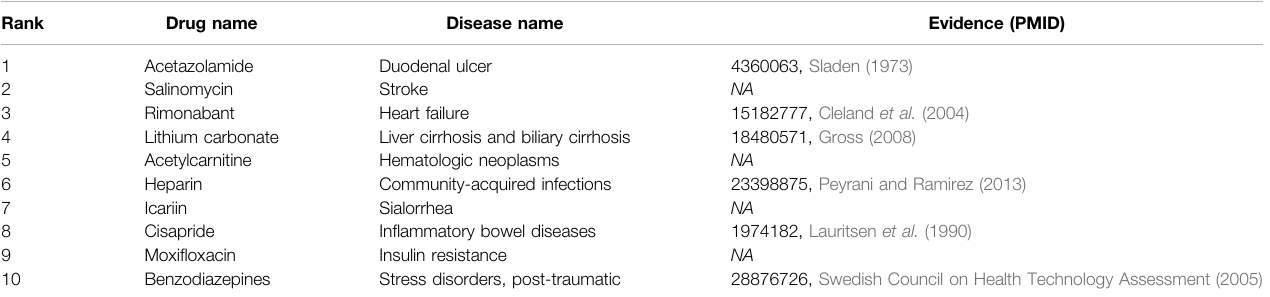
TABLE 5 | Top 10 repositioned drugs predicted by the DRGCC.